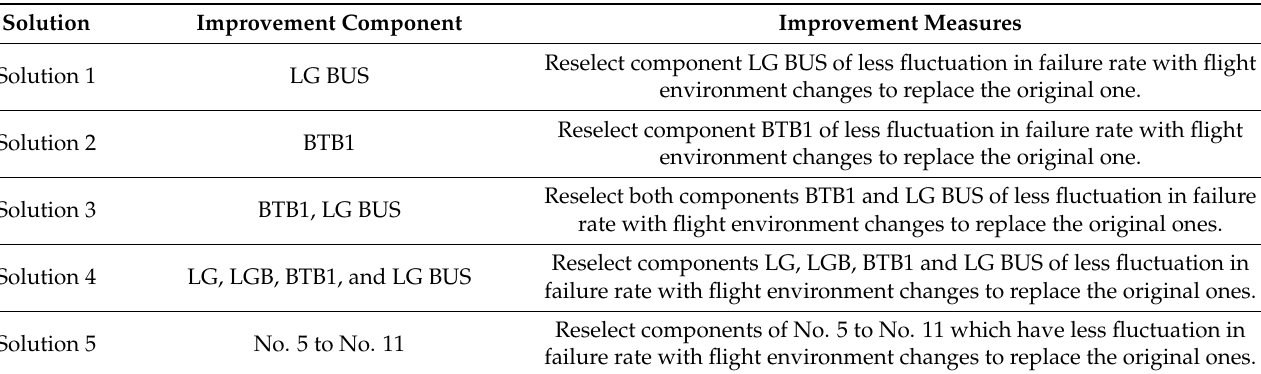
Table 5. Five system reliability improvement/optimization